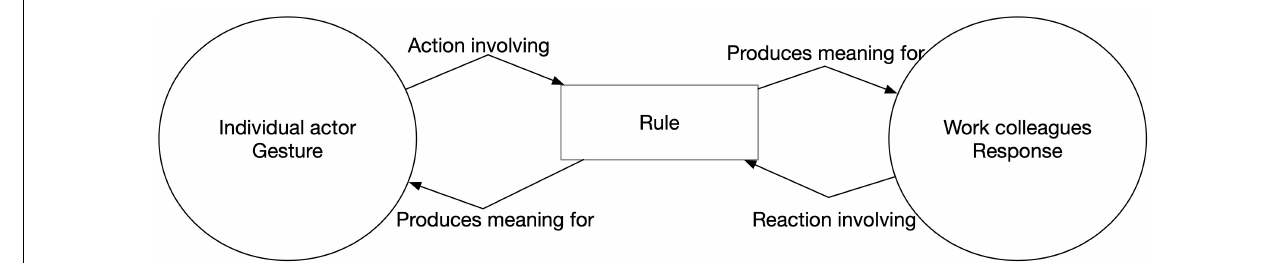
FIGURE 1 | Autonomy as a rule